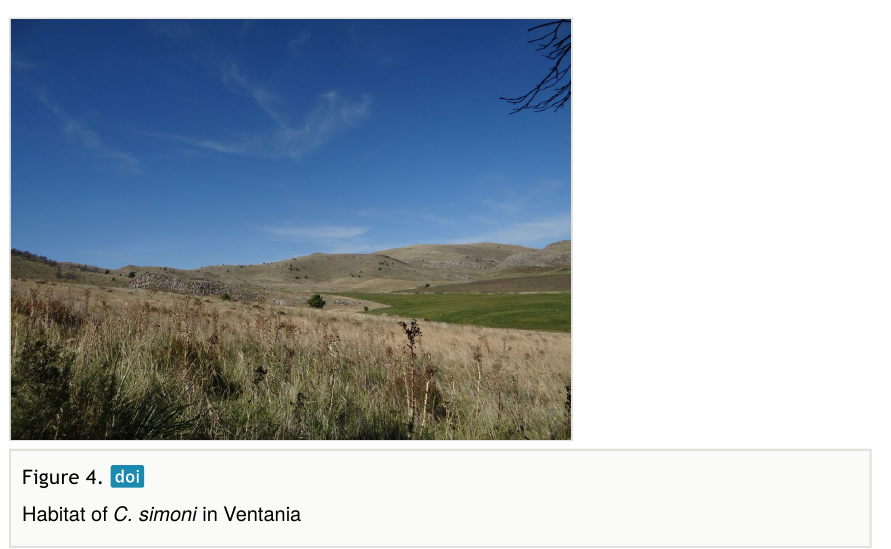
Population Information (Narrative) Four subpopulations are known for this species. Two subpopulations are located at the Ventania mountain system Fig. 4 and the other two subpopulations are located at the Tandilia mountain system.